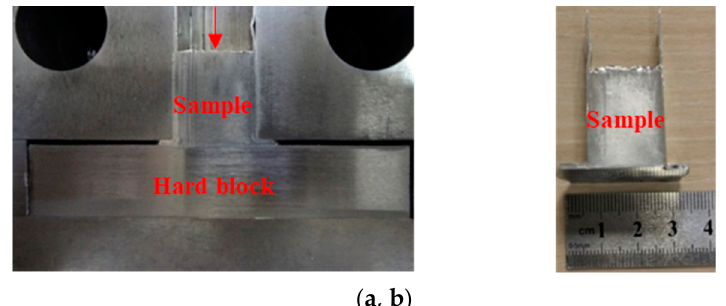
Figure 3. ( a ) Experimental setup for T-NECAP for Al-1050. ( b ) The sample obtained after processing.